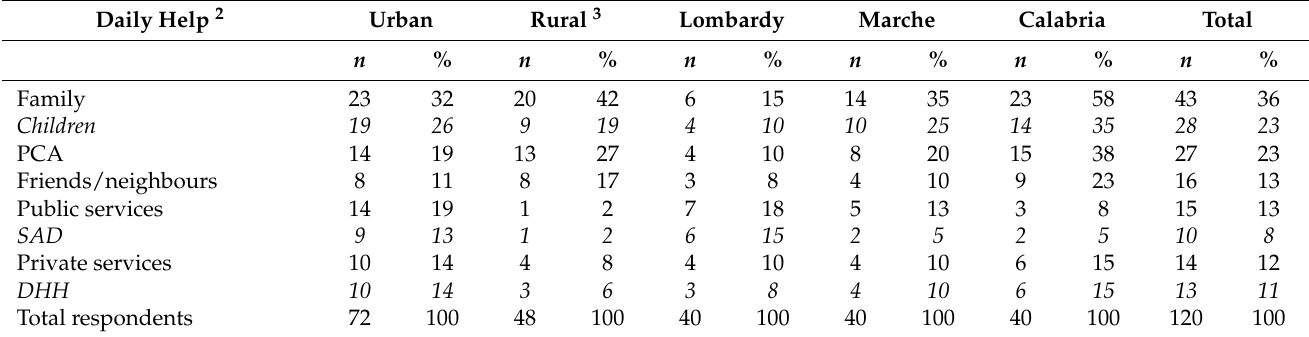
Table 9. Daily help, by sites and regions (at least one daily help by type) 1